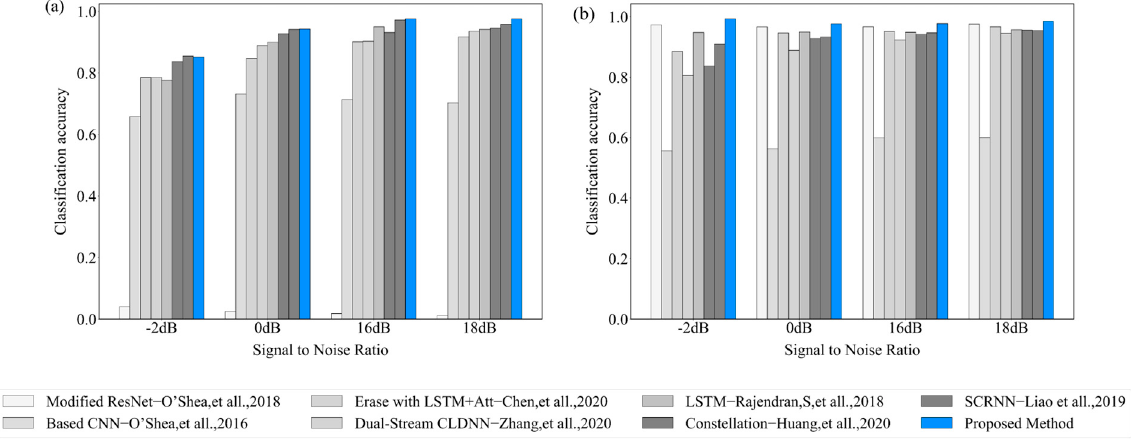
Figure 14. Comparison of recognition accuracy of QAM16 and QAM64 with different models. ( a )